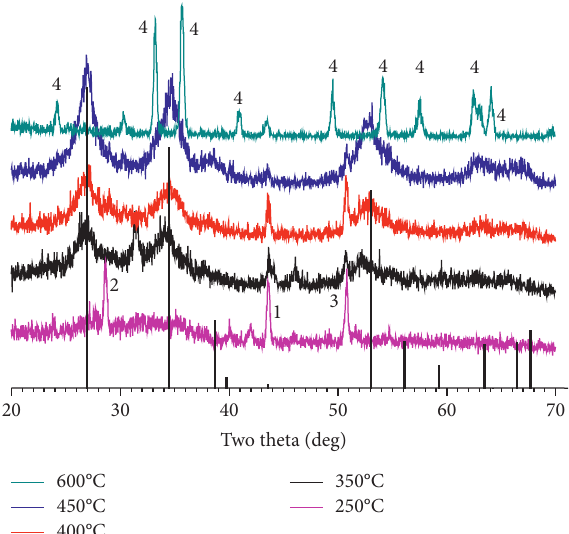
Figure 1: XRD patterns of SnO 2 -doped Sb coatings on 316L stainless steel at various annealing temperatures. The peaks of SnO 2 (adapted from [7]) are presented as the vertical black bars and 1, NiO (JCPDS 78-0643); 2, Sb 2 O 3 (JCPDS 42-1466); 3, Sb 2 O 4 (JCPDS 37-0854); 4, Cr 2 O 3 (JCPDS